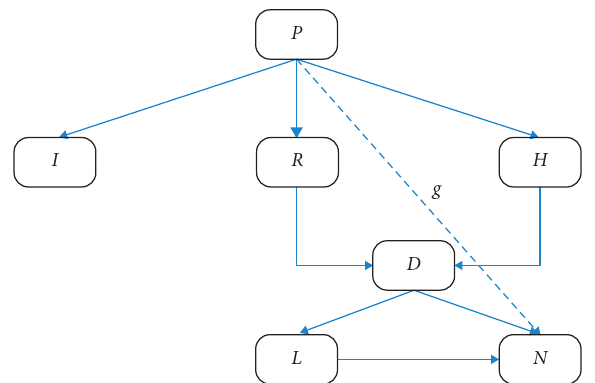
Figure 3: Structure of the states of the population narcotization